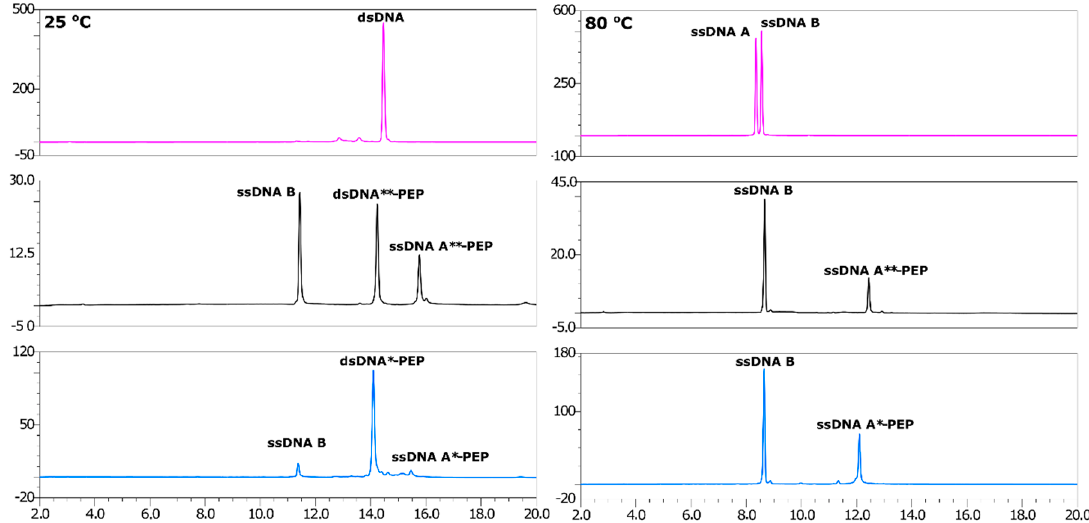
Figure 3. HPLC ( left ) and denaturative HPLC (dHPLC)—( right ) analysis of the dsDNA product obtained after annealing ssDNA peptide conjugates. Purple—non-labeled dsDNA, black—dsDNA**- PEP, blue—dsDNA*-PEP. HPLC conditions: XBridge OST reverse-phase C18 column; mobile phases A: 50 mM triethylamine acetate (TEAA) and 1% acetonitrile in water, B: 80% ACN in water; a gradient of 0–20%/20 min B was used, maintaining 1 mL/min flow rate; recorded at 260 nm. The picture clearly presents the high purity of obtained double stranded DNA systems—almost no other peaks visible.